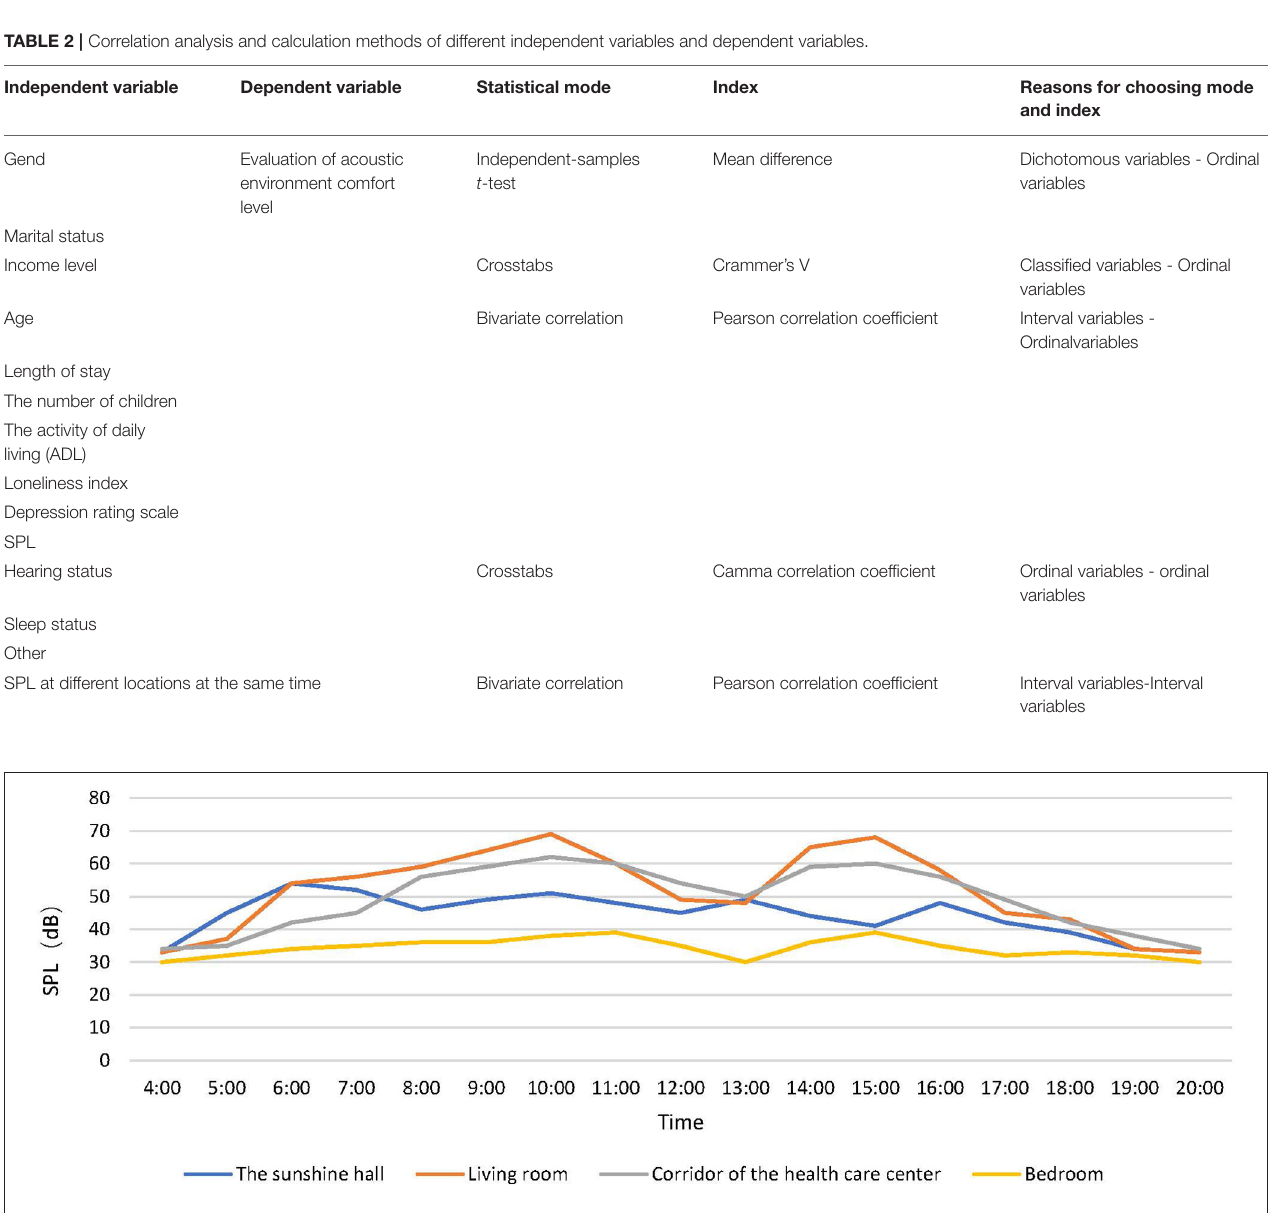
FIGURE 2 | Daily SPL(A) distribution in four kinds of